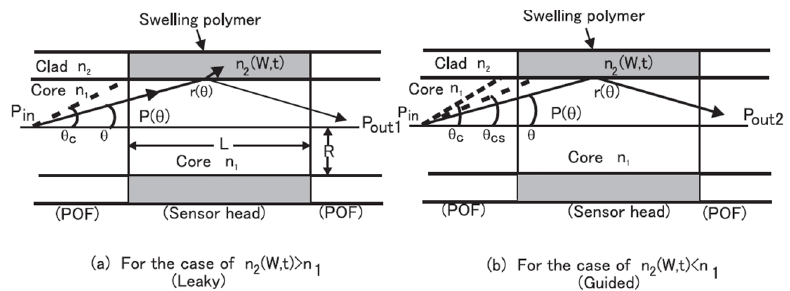
Figure 7. Point sensor. A simulation model of the POF-based humidity sensor involving ray optics. ( a ) For the case of leaky rays ( b ) For the case of guided rays. Reprinted with permission from ref. [32]. Copyright 2003 IOPscience